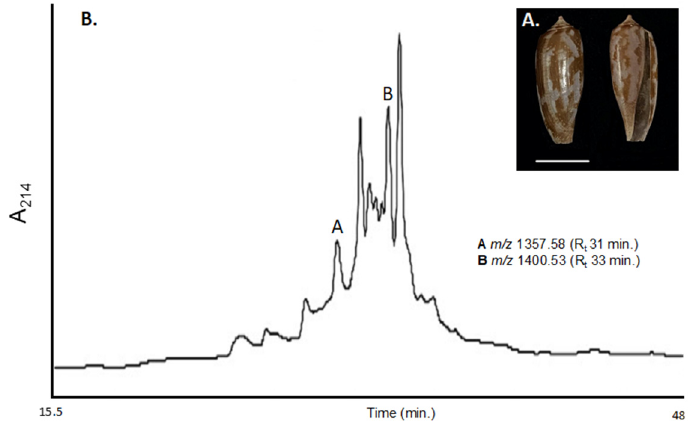
Figure 1. ( A ) Conus obscurus shell found off Oahu, Hawai’i, USA. Scale bar 1 cm; ( B ). RP-HPLC/UV profile of the Tris(2-carboxyethyl) phosphine (TCEP) reduced, pooled milked venom from Conus obscurus extracted at 214 nm. Peaks corresponding to α -conotoxin SI and α -conotoxin OI are indicated, as well as their observed TCEP reduced m/z . TCEP reduction of whole MV increased peak resolution and improved peptide isolation. See Supplementary Figure S1 for total m/z observed within the crude TCEP reduced MV.